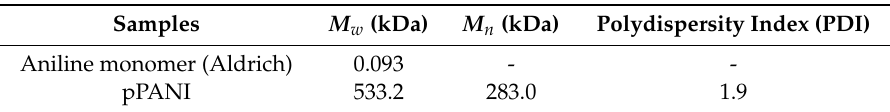
Table 1. Summary of calculated molecular weights of pPANI NwN thin film obtained by gel permeation chromatography (GPC) prepared using